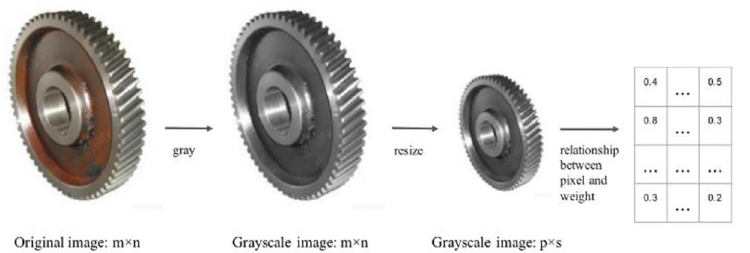
Fig 3. The pixel-based attention map generation approach.